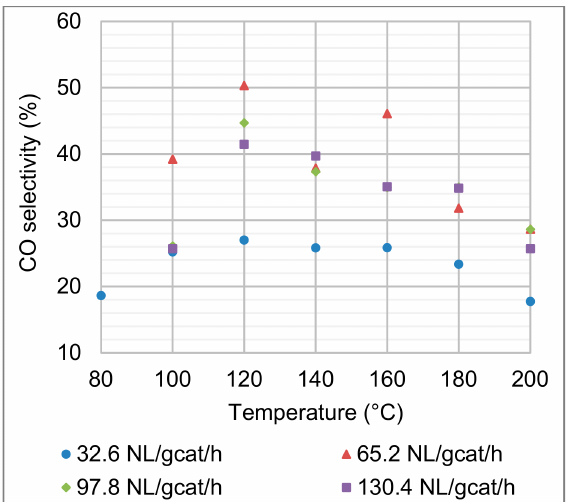
Figure 5. Effects of reaction temperature and space velocity on the CO selectivity. Feed composition: 68.6 vol.% H 2 , 1.4 vol.% CO, 10 vol.% CO 2 , 2 vol.% O 2 , and 18 vol.% N 2